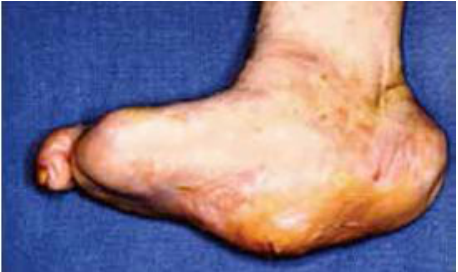
Figure 5. Rocker bottom deformity in